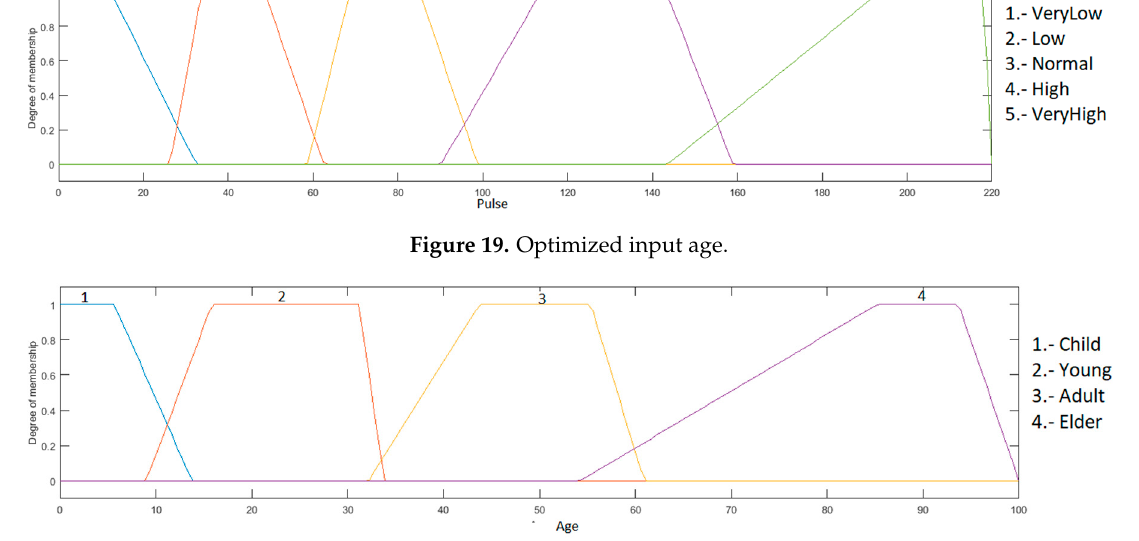
Figure 20. Optimized input heart